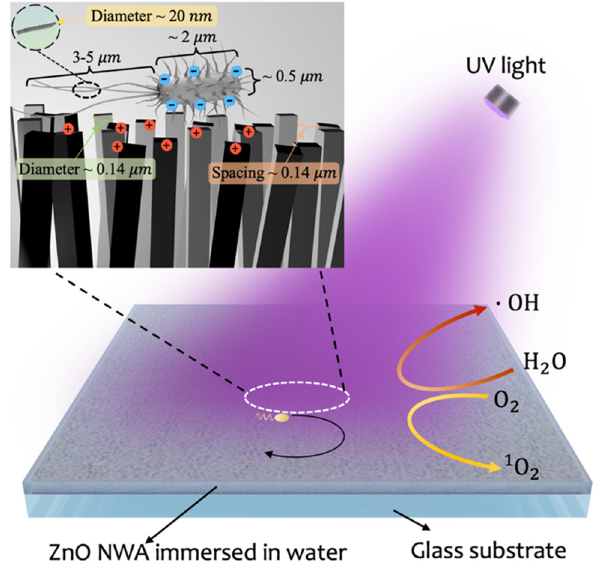
Figure 6. Sketch of bacterial swimming on ZnO NWA. Generation of hydroxyl radical and singlet oxygen are initiated in the presence of UV irradiation.